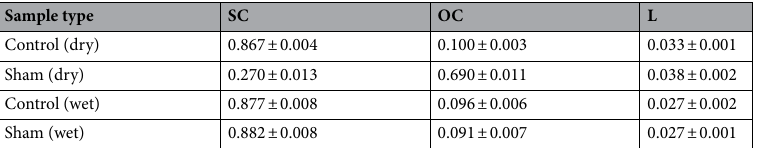
Table 1. Comparison of the proportions of supercoiled (SC), open-circular (OC) and linear (L) plasmid in control and sham (unirradiated samples transported to and from CLEAR) plasmid samples. Standard error based on three gel electrophoresis repeats and four control samples for each